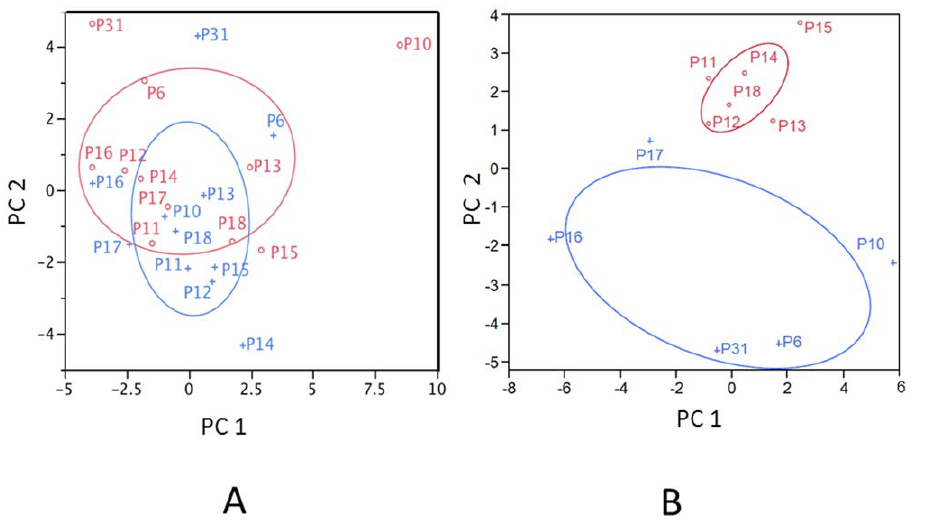
Figure 6. Comparisons of Principal Component Analysis Plots: Before vs. After Transplantation and NoRSS vs. RSS. Bivariate plots of principal component 1 (PC1) and principal component 2 (PC2) compare before vs. after transplantation in Plot A and RSS vs. NoRSS in Plot B. Plot A shows overlapping density ellipse between before transplantation (blue cross) and after transplantation (red open circle) groups may indicate lack of significant difference in expression between the two groups. Plot B depicts a density ellipse drawn with 50% confidence of the mean for each group. Lack of overlap of density ellipse between the RSS (blue cross) and NoRSS (red open circle) samples indicates a possible significant difference in expression between the two groups. NoRSS=patients who do not develop respiratory signs and symptoms. RSS=patients who develop respiratory signs and symptoms.